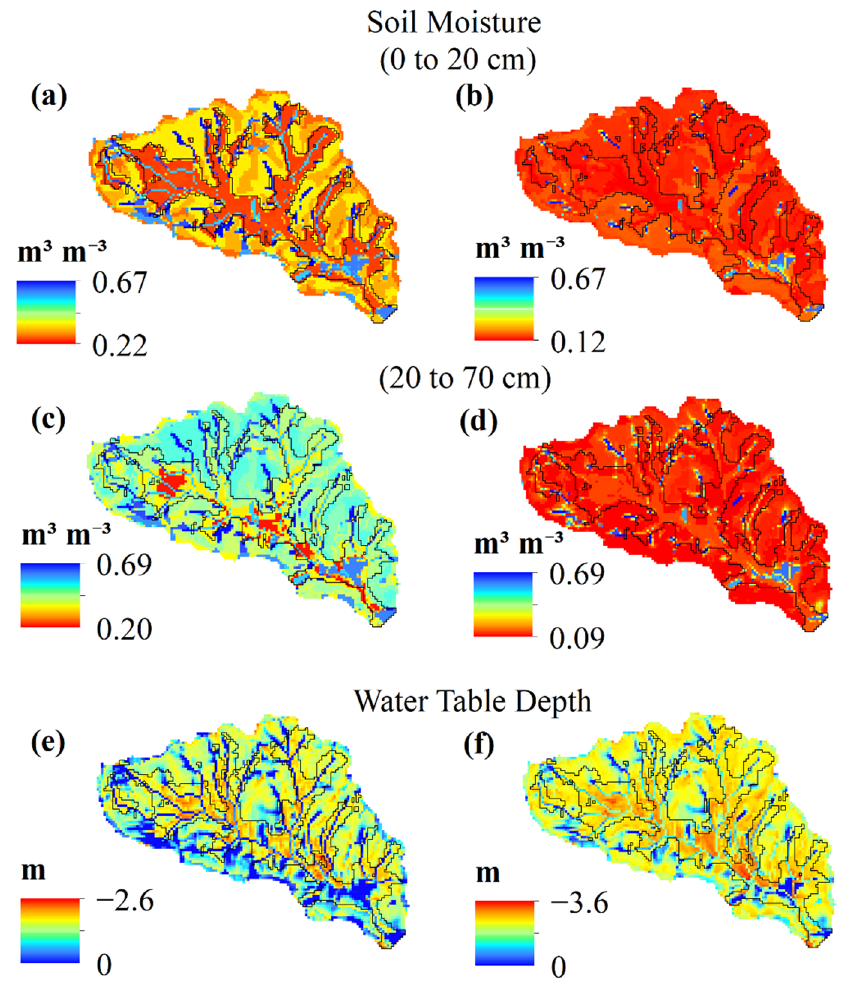
Figure 9. Soil moisture (m 3 m −3 ) in the layers from 0 to 20 cm ( a , b ) and 20 to 70 cm ( c , d ) and water table depth ( e , f ); on 3 February 2008 (left column) and 11 August 11 2007 (right column), simulated by the DHSVM in the LCW, black contour line outlines the Geomorphons features “hollow”, “valley”, and “pit”.